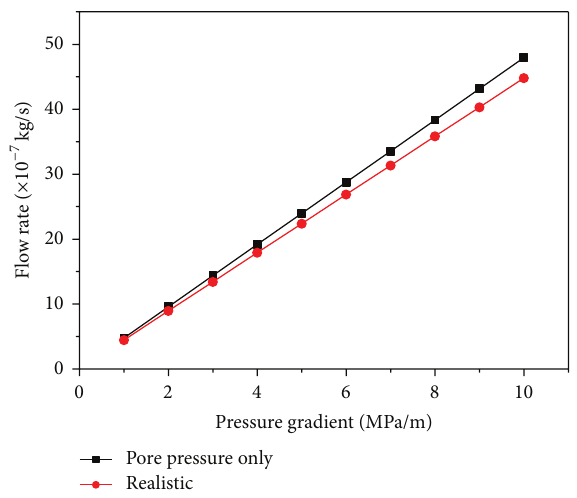
Figure 7: Flow rate of outlet versus fluid pressure gradient. The red curve is traditional simulation that does not consider the hydromechanical coupling; the black curve illustrates the state of hydromechanical coupling when the confining pressure is regarded as 0 and the pore pressure is 2 MPa.